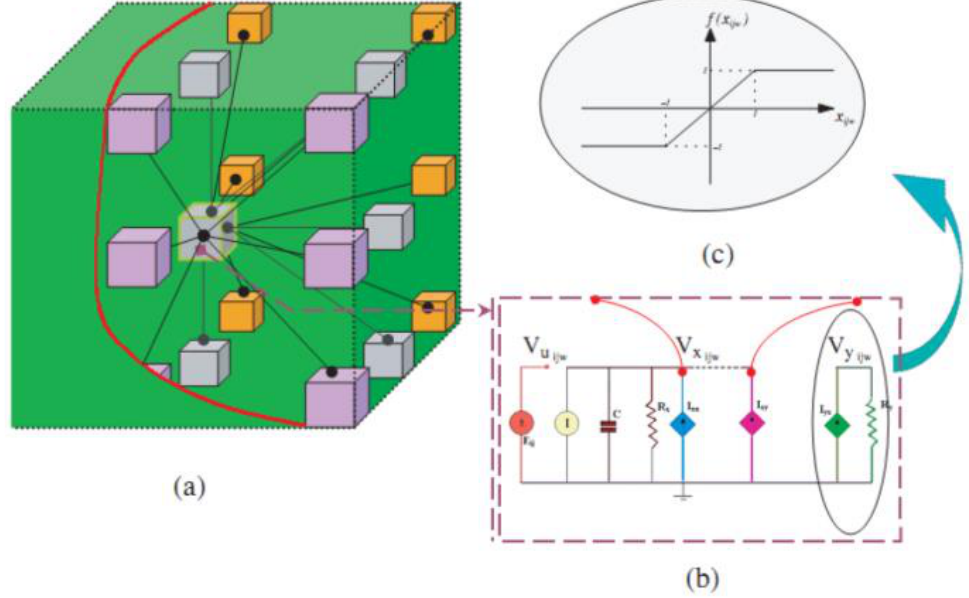
Figure 2. CNN architecture: ( a ) spatial interactions; ( b ) circuit implementation; ( c ) output.